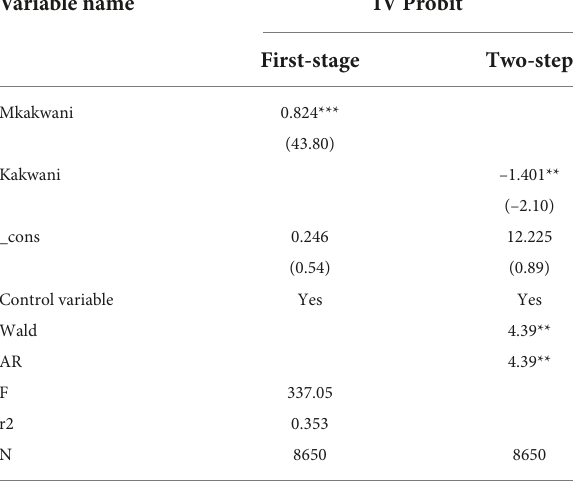
TABLE 3 Instrumental variable estimation